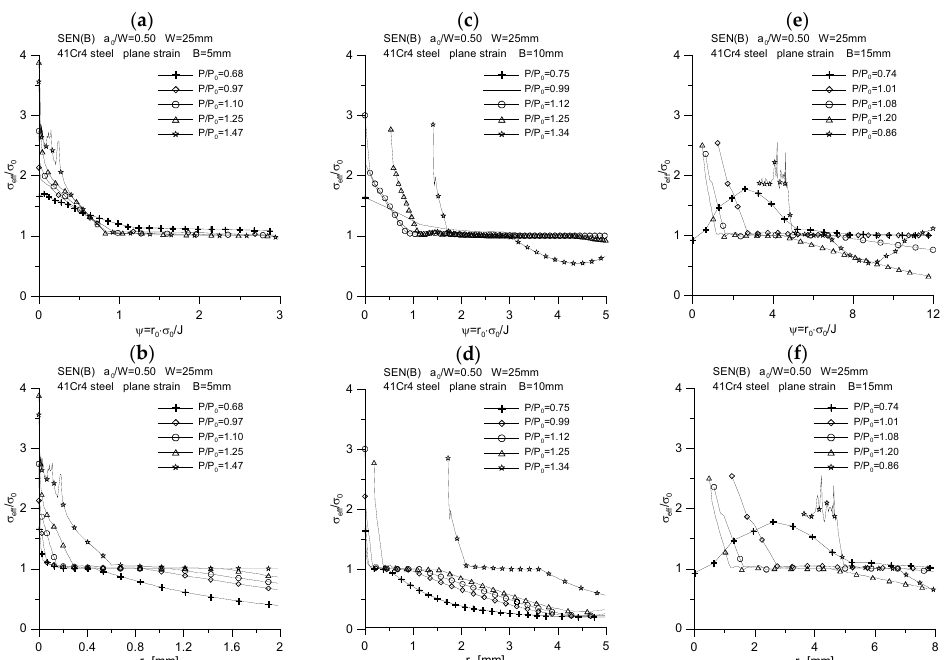
Figure 10. The distribution of effective stresses, σ eff / σ 0 , for three specimens used in the crack propagation simulation. The graphs ( a , c , e ) were made for the normalized distance from the crack tip, ψ = r 0 ∙ σ 0 / J , while the graphs ( b , d , f ) were prepared for the physical distance from the initial crack tip position, r 0 . The figures show the distributions for the characteristic moments provided in Table 2. Figure 11 shows the influence of the external load and the distance from the crack tip on the distribution of the quotient of average stresses and effective stresses. The quotient , with the approach to the crack tip, reaches a maximum, the value of which only of (cid:3097) (cid:3288) (cid:3097) (cid:3280)(cid:3281)(cid:3281) slightly depends on the thickness of the specimen and the applied external load. There is with increasing specimen a slight increase in the maximum value of the quotient (cid:3097) (cid:3288) (cid:3097) (cid:3280)(cid:3281)(cid:3281) thickness, as well as a quite significant increase with increasing external load. For a spec ‐ imen with a thickness of B = 5 mm, the quotient (cid:3097) (cid:3288) (cid:3097) (cid:3280)(cid:3281)(cid:3281) does not exceed the value equal to 3, while for the thicknesses B = 10 and B = 15 mm, the quotient (cid:3097) (cid:3288) (cid:3097) (cid:3280)(cid:3281)(cid:3281) for significant increases in the crack length reaches the value equal to 3.5. It can be noticed that the distributions of the quotient (cid:3097) (cid:3288) (cid:3097) (cid:3280)(cid:3281)(cid:3281) in their graphic form resemble the diagrams of changes of average stresses, normalized by the yield point. As the crack crest is approached, the value of the quotient (cid:3097) (cid:3288) (cid:3097) (cid:3280)(cid:3281)(cid:3281) increases, which reaches its maximum, and then the value of this quotient decreases. The position of the maximum of the ratio (cid:3097) (cid:3288) (cid:3097) (cid:3280)(cid:3281)(cid:3281) is closely related to the external load—the higher its value, the further the maximum of the quotient (cid:3097) (cid:3288) (cid:3097) (cid:3280)(cid:3281)(cid:3281) physically is from the initial position of the crack tip. Figure 12, for one of the geometries considered in the study (specimen with a thick ‐ ness of B = 5 mm), shows how the levels of the principal components of the stress tensor, effective stresses and mean stresses change at different normalized points near the crack tip, depending on the external load expressed by the J ‐ integral value. It should be noted that the standardized position in front of the crack tip, marked with ψ , was determined in